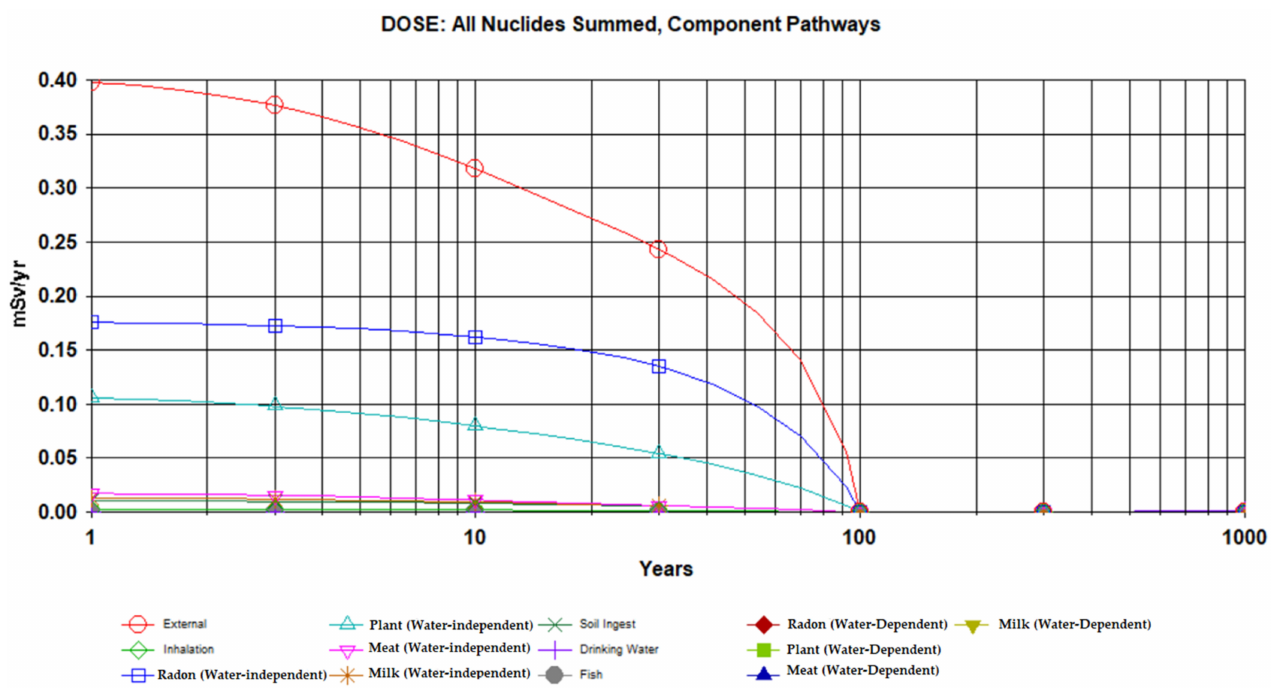
Figure 4. Dose contributions from all nuclides summed and for all exposure pathways.